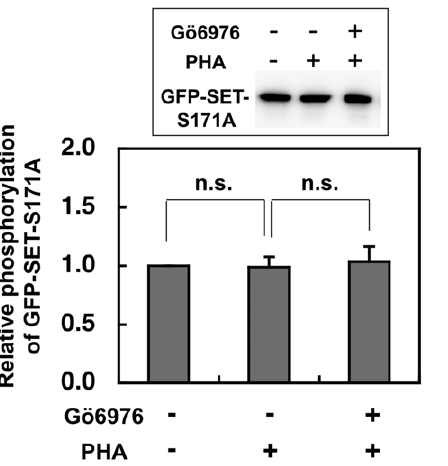
Figure 5. Substitution of Ser171 to Glu (SET-S171E) in SET compromised its inhibitory effect on PP2A. Substitution of Ser171 to Glu (SET-S171E), which mimics phosphorylated SET at Ser171 residue, reduced its inhibitory effect on PP2A compared with Ser171 to Ala substitution (SET-S171A) or wild-type SET did. (A) The phosphatase activity of PP2A (37 m U) under the presence of indicated concentration of recombinant SET was monitored by using 32 P-labeled MBP as a substrate. After SET proteins and PP2A were preincubated for 15 min at 4 u C, 32 P-MBP was added and incubated for 10 min at 37 u C. The reaction mixture was separated with SDS-PAGE. The inhibitory effect of SET proteins on PP2A activity was visualized by exposing the SDS-PAGE gel with PP2A-treated 32 P-MBP to X-ray film. The data shown are representative results from three independent experiments with similar results. (B) The relative PP2A activity to the radioactivity of 32 P-MBP without SET (assigned to be 1) was calculated from the radioactivity of MBP bands in the dried gel shown in (A). Values represent the means 6 SD from three independent experiments.